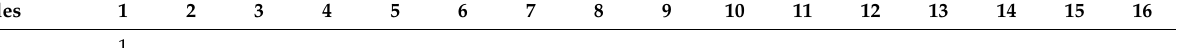
Table 6. Descriptive statistics and zero-order correlations (H2.1 and